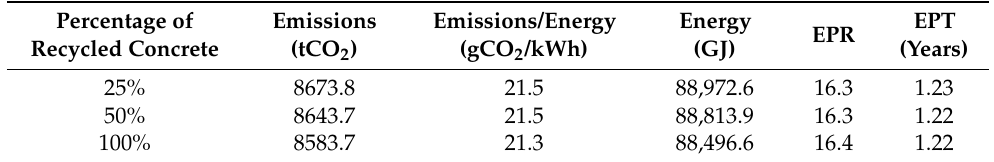
Table 10. CO 2 emissions and energy consumption for the project considering different levels of recycled concrete.